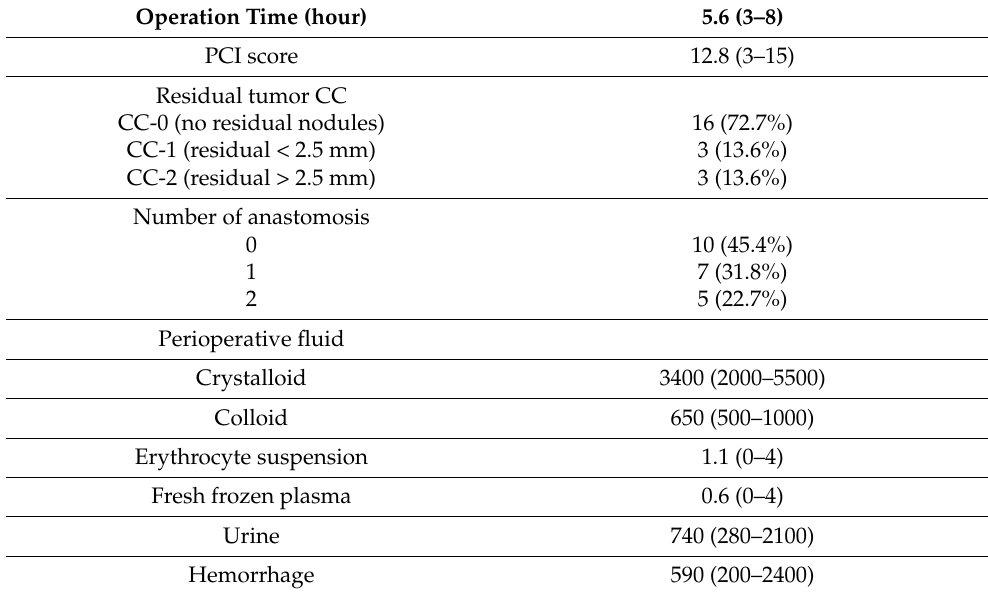
Table 2. Perioperative findings.